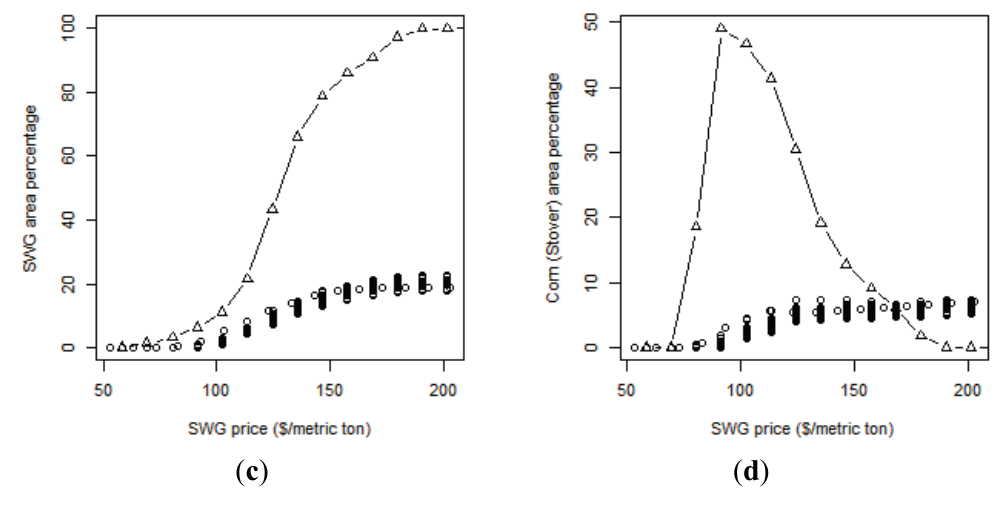
Figure 5. Crop area percentages (( a ) corn—no stover; ( b ) soybean; ( c ) switchgrass; ( d ) corn—stover) from 36 simulations (36 SWG price levels and fixed switchgrass to corn stover price ratio of 1.31) on the basis of with (dots) vs. without (triangles in dashed line) land use survey information included.